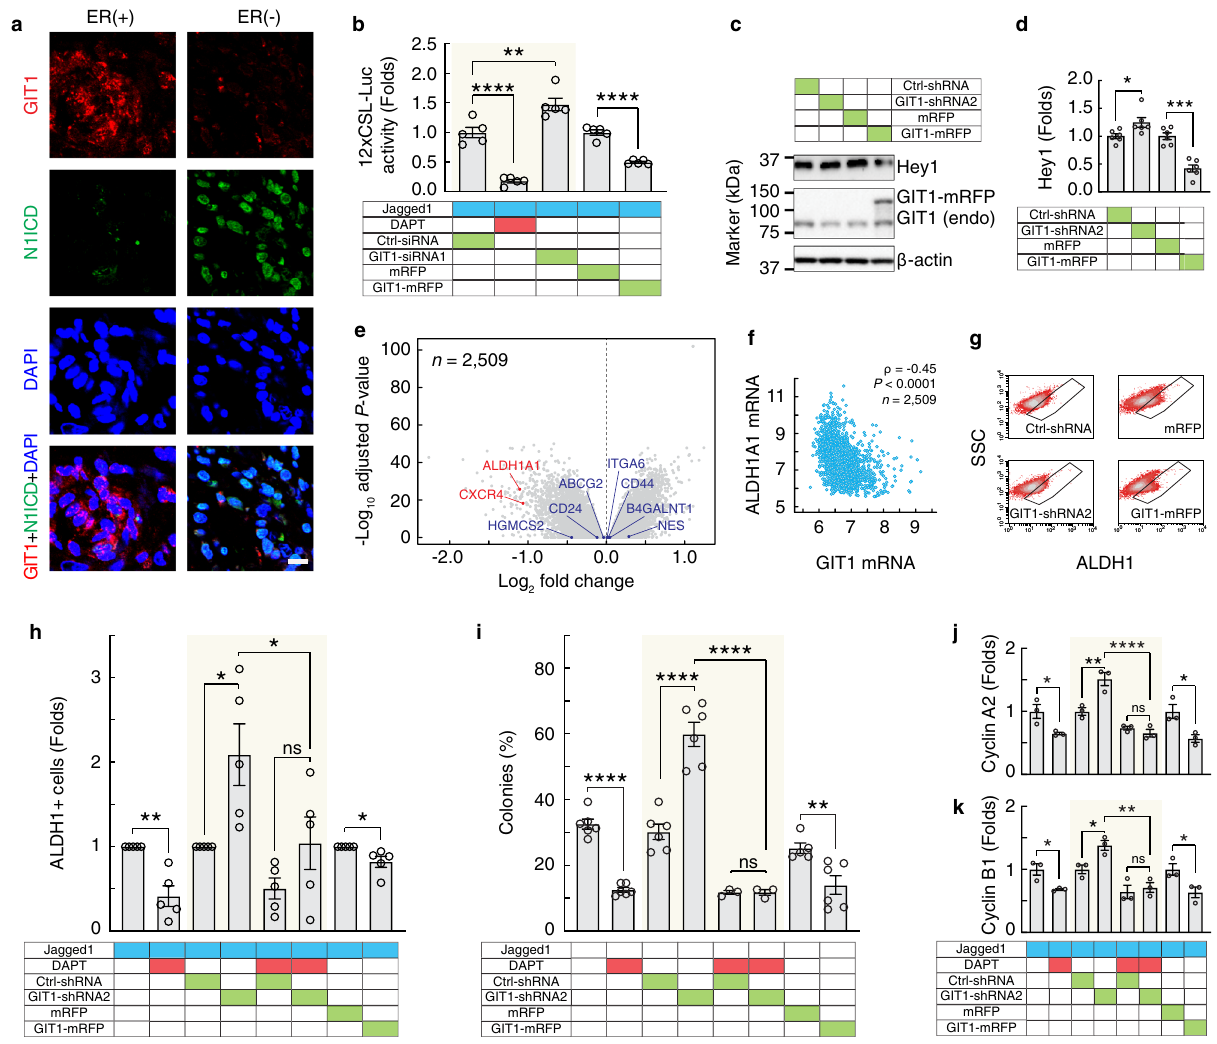
Jagged1 DAPT Ctrl-shRNA GIT1-shRNA2 mRFP GIT1-mRFP Fig. 2 GIT1 regulates Notch signalling, ALDH1 activity, and colony formation. a Immunostaining of GIT1 and Notch1 ICD (N1ICD) in one ER( + ) and one ER( − ) breast cancer sample. Nuclei were detected using DAPI. Images from representative micrographs; the experiment was repeated n = 6 times for ER( + ) samples and n = 4 times for ER( − ) samples with similar results. Scale bar, 10 μ m. b – d Luciferase reporter assays of 12xCSL-Luc ( b ; n = 5, Ctrl-siRNA versus DAPT, P < 0.0001; Ctrl-siRNA versus GIT1-siRNA1, P = 0.0038; one-way ANOVA, F 2,12 = 64.17, P < 0.0001 (shaded area); mRFP versus GIT1- mRFP, P < 0.0001; t tests) and western blots of Hey1 ( c ) and the quantitative analysis ( d ; n = 6, Ctrl-shRNA versus GIT1-shRNA2, P = 0.030; mRFP versus GIT1-mRFP; P = 0.0002; t tests) in MDA-MB-231 cells treated as indicated. e , f Volcano plot of differentially expressed genes for high and low GIT1 e ; n = 2509 patients) and a correlation analysis between GIT1 and ALDH1A1 mRNA expression ( f ; n = 2509 patients, Spearman ρ = − 0.45, P < 0.0001) in breast cancer samples from the METABRIC database 63 . Breast cancer stemness genes are indicated. g , h Flow cytometric analysis of Alde fl uor-assayed MDA-MB-231 cells treated as indicated ( g ) and the quantitative analysis ( h ; n = 5, vehicle versus DAPT, P = 0.0014, t test; Ctrl-shRNA versus GIT1- shRNA2, P = 0.031; GIT1-shRNA2 versus GIT1-shRNA2 + DAPT, P = 0.040; Ctrl-shRNA + DAPT versus GIT1-shRNA2 + DAPT, P = 0.44; one-way ANOVA, F 3,16 = 7.216, P = 0.0028 (shaded area); mRFP versus GIT1-mRFP, P = 0.025, t test). SSC, side scatter. i Clonogenic assay of MDA-MB-231 cells treated as indicated ( n = 6, vehicle versus DAPT, P < 0.0001, t test; Ctrl-shRNA versus GIT1-shRNA2, P < 0.0001; GIT1-shRNA2 versus GIT1- shRNA2 + DAPT, P < 0.0001; Ctrl-shRNA + DAPT ( n = 3) versus GIT1-shRNA2 + DAPT ( n = 3), P = 1.00; one-way ANOVA, F 3,14 = 57.84, P < 0.0001 (shaded area); mRFP ( n = 5) versus GIT1-mRFP ( n = 6), P = 0.010, t test). j , k Quantitative analyses of Cyclin A ( j ; n = 3, vehicle versus DAPT, P = 0.036, t test; Ctrl-shRNA versus GIT1-shRNA2, P = 0.0032; GIT1-shRNA2 versus GIT1-shRNA2 + DAPT, P < 0.0001; Ctrl-shRNA + DAPT versus GIT1- shRNA2 + DAPT, P = 0.84; one-way ANOVA, F 3,8 = 32.06, P < 0.0001 (shaded area); mRFP versus GIT1-mRFP, P = 0.028, t test) and Cyclin B1 ( k ; n = 3, vehicle versus DAPT, P = 0.024, t test; Ctrl-shRNA versus GIT1-shRNA2, P = 0.049; GIT1-shRNA2 versus GIT1-shRNA2 + DAPT, P = 0.0022; Ctrl- shRNA + DAPT versus GIT1-shRNA2 + DAPT, P = 0.94; one-way ANOVA, F 3,8 = 15.92, P = 0.0010 (shaded area); mRFP versus GIT1-mRFP, P = 0.043, t test) from western blots of MDA-MB-231 cells treated as indicated. All data are shown as the mean ± s.e.m. n denotes the number of biologically independent replicates, unless stated otherwise. * P < 0.05, ** P < 0.01, *** P < 0.001, **** P < 0.0001, ns, not signi fi cant by two-sided unpaired t tests or one- way ANOVA with Tukey ’ s post hoc comparison. Source data are provided as a Source Data fi